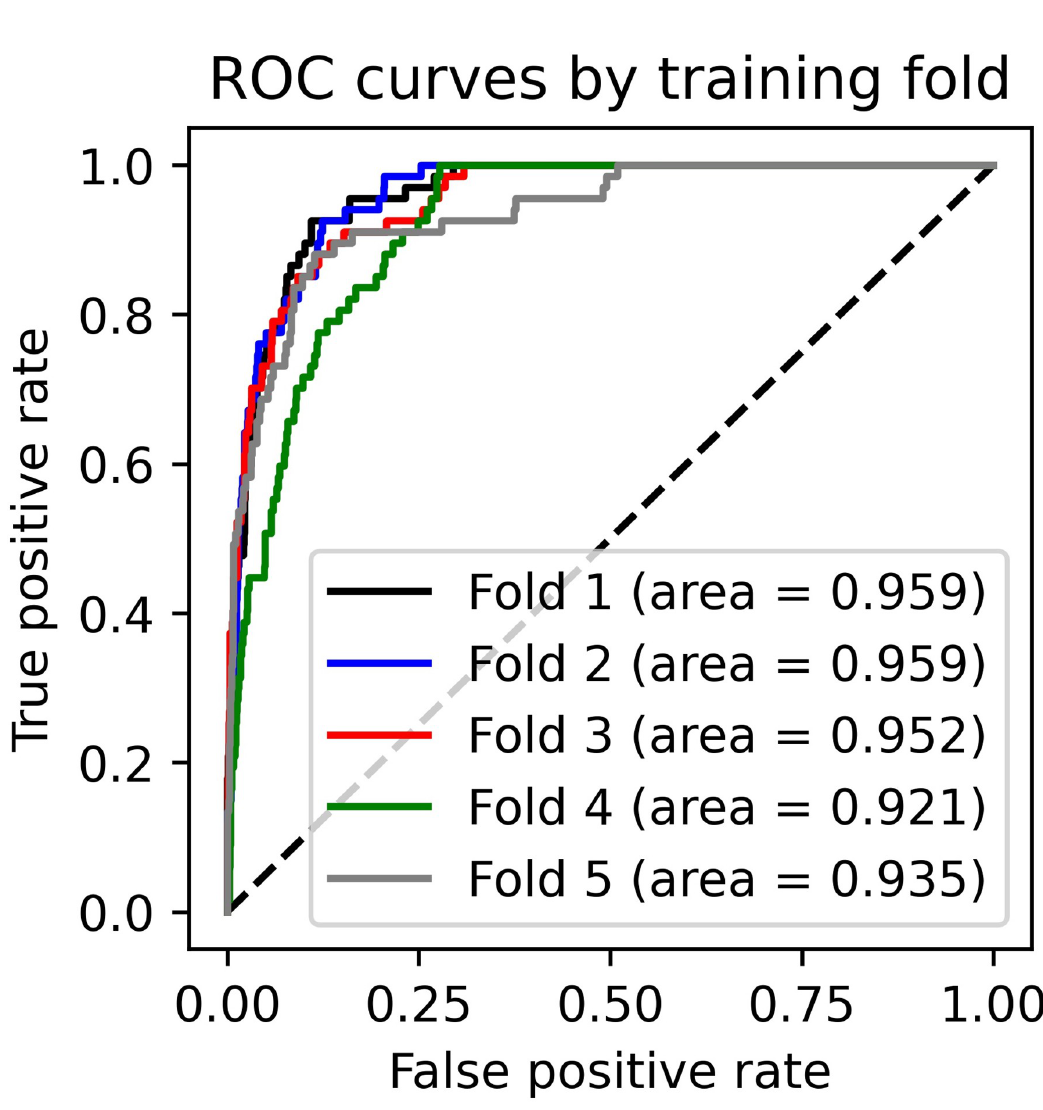
Fig 4. ROC curves for all folds and all model iterations, hybrid CNN-MLP model. Dotted line displays expected TRP-FPR curve for a fully random classifier. Fig source: